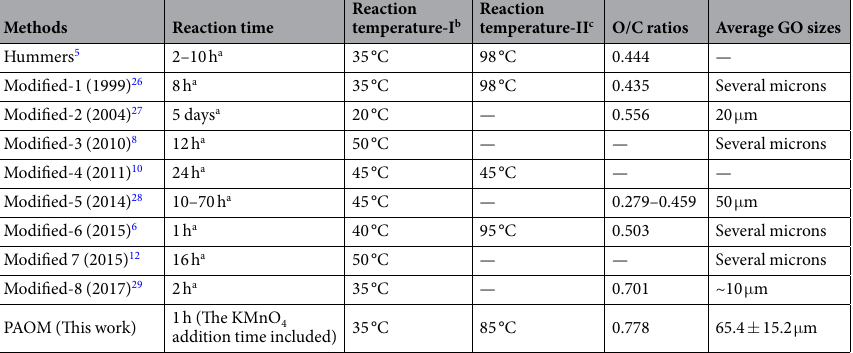
Table 2. The comparison of the Hummers-modified approaches and products. a The addition time of KMnO 4 (slow addition) is not included. b Reaction temperatures after H 2 SO 4 mixing with graphite flakes. c Reaction temperatures after adding DI